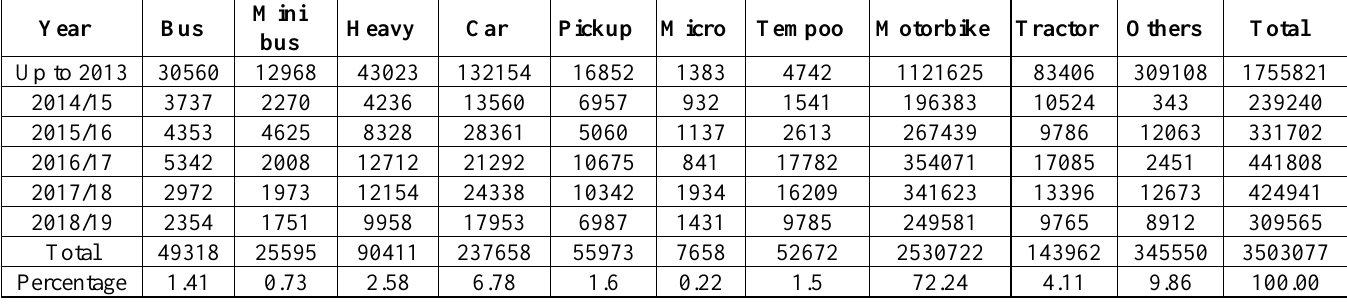
Table 29: Vehicle Composition: Registration Data.